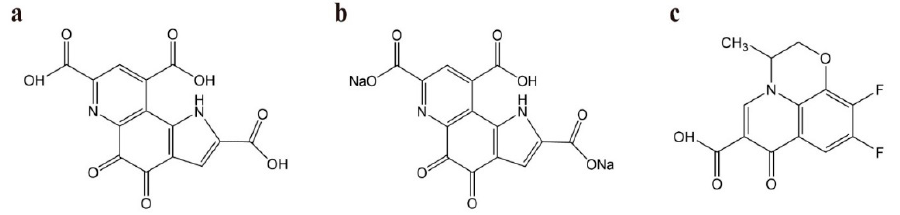
Figure 1. The chemical structure of PQQ ( a ), PQQ disodium salt ( b ) and IS ( c ).